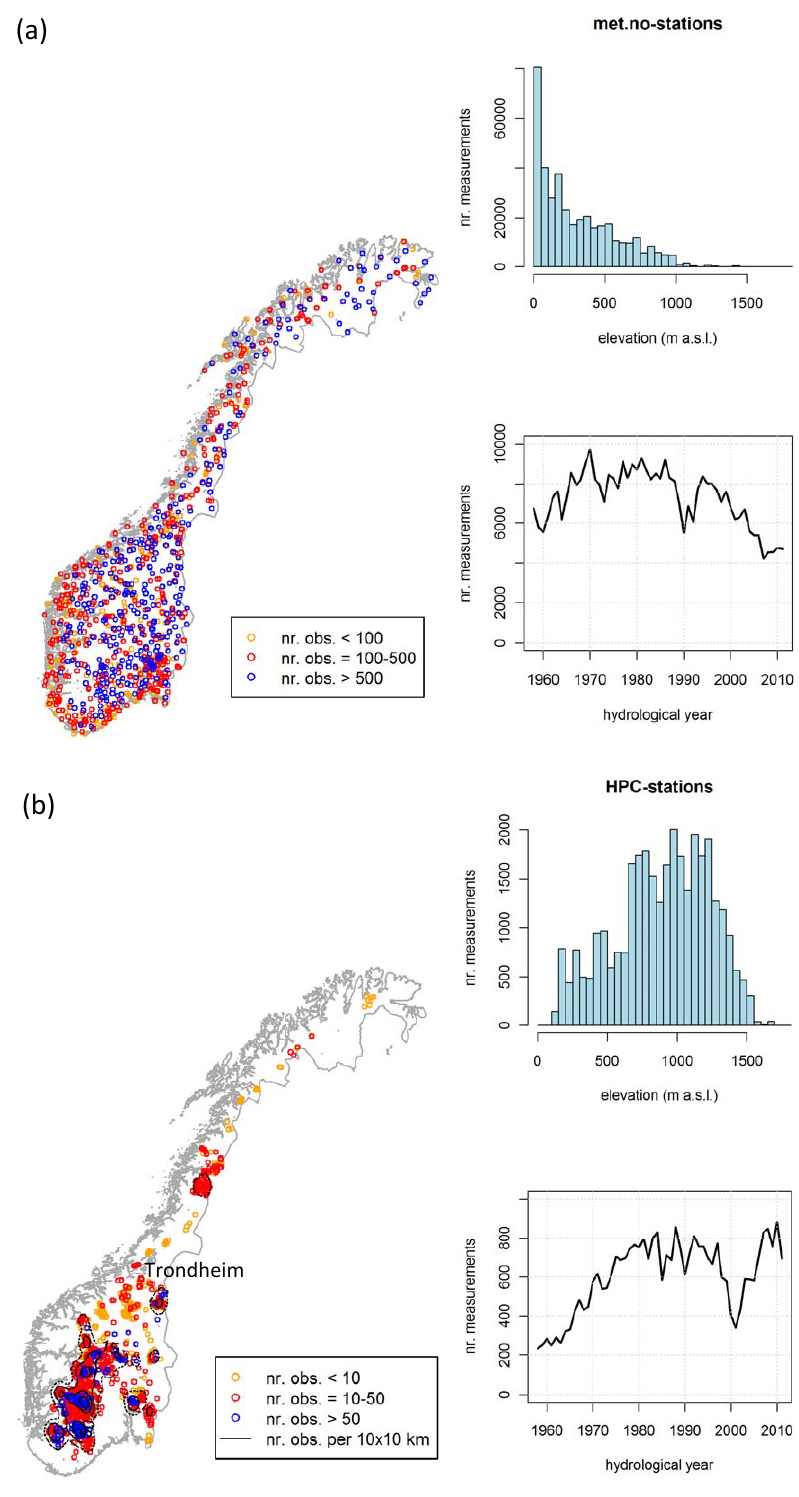
Figure 1. Spatiotemporal distribution of the snow measurements in the (a) met.no-data (392547 samples in total, varying from 10 to 1170 per station) and (b) HPC-data (32256 samples in total, varying from 1 to 239 per station) from 1957–2011. The colours in the map denote the number of observations per station, as indicated in the legend. The contours in (b) show the number of samples per 10 × 10km grid cells (dashed contours denote 15 samples, solid contours 50, 100 and 150 samples), and the city of Trondheim marks the division line between southern and northern Norway.